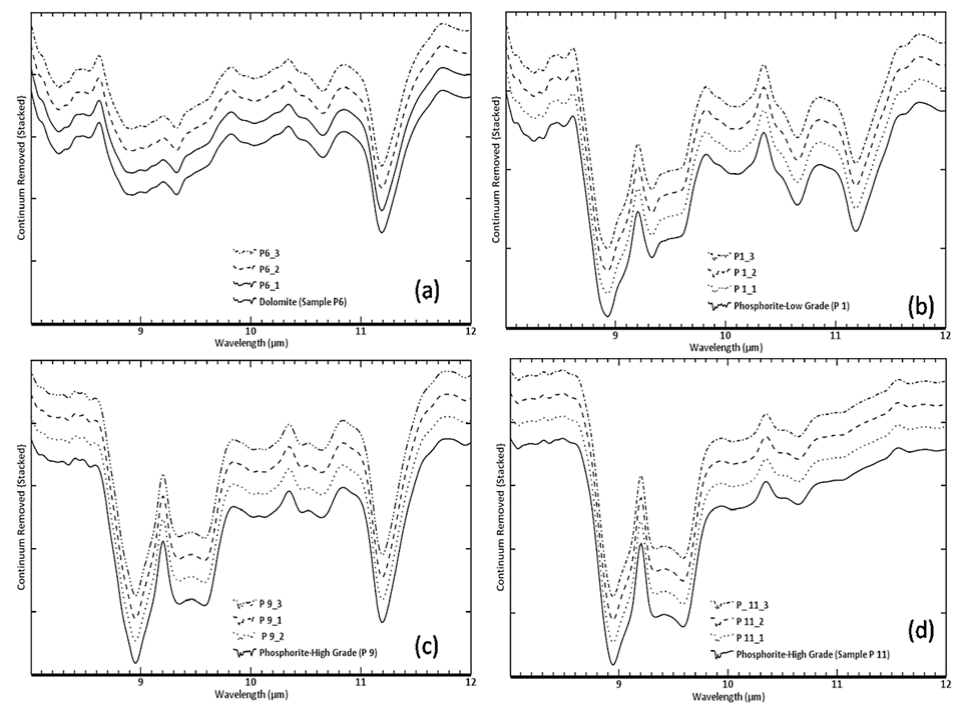
Figure 5. ( a ) Emissivity spectra of di ff erent samples of host rock dolomite(di ff erent samples of same rock type are denoted P6_1, P6_2, and so on). ( b ) Emissivity spectra of di ff erent samples of low-grade phosphorite (di ff erent samples of same rock type are denoted P1_1, P1_2, and so on). ( c ) Emissivity spectra of medium to high-grade phosphorite (di ff erent samples of same rock type are denoted P9_1, P9_2, and so on). ( d ) Emissivity spectra of high-grade phosphorite (di ff erent samples of same rock type are denoted P11_1, P11_2, and so on).